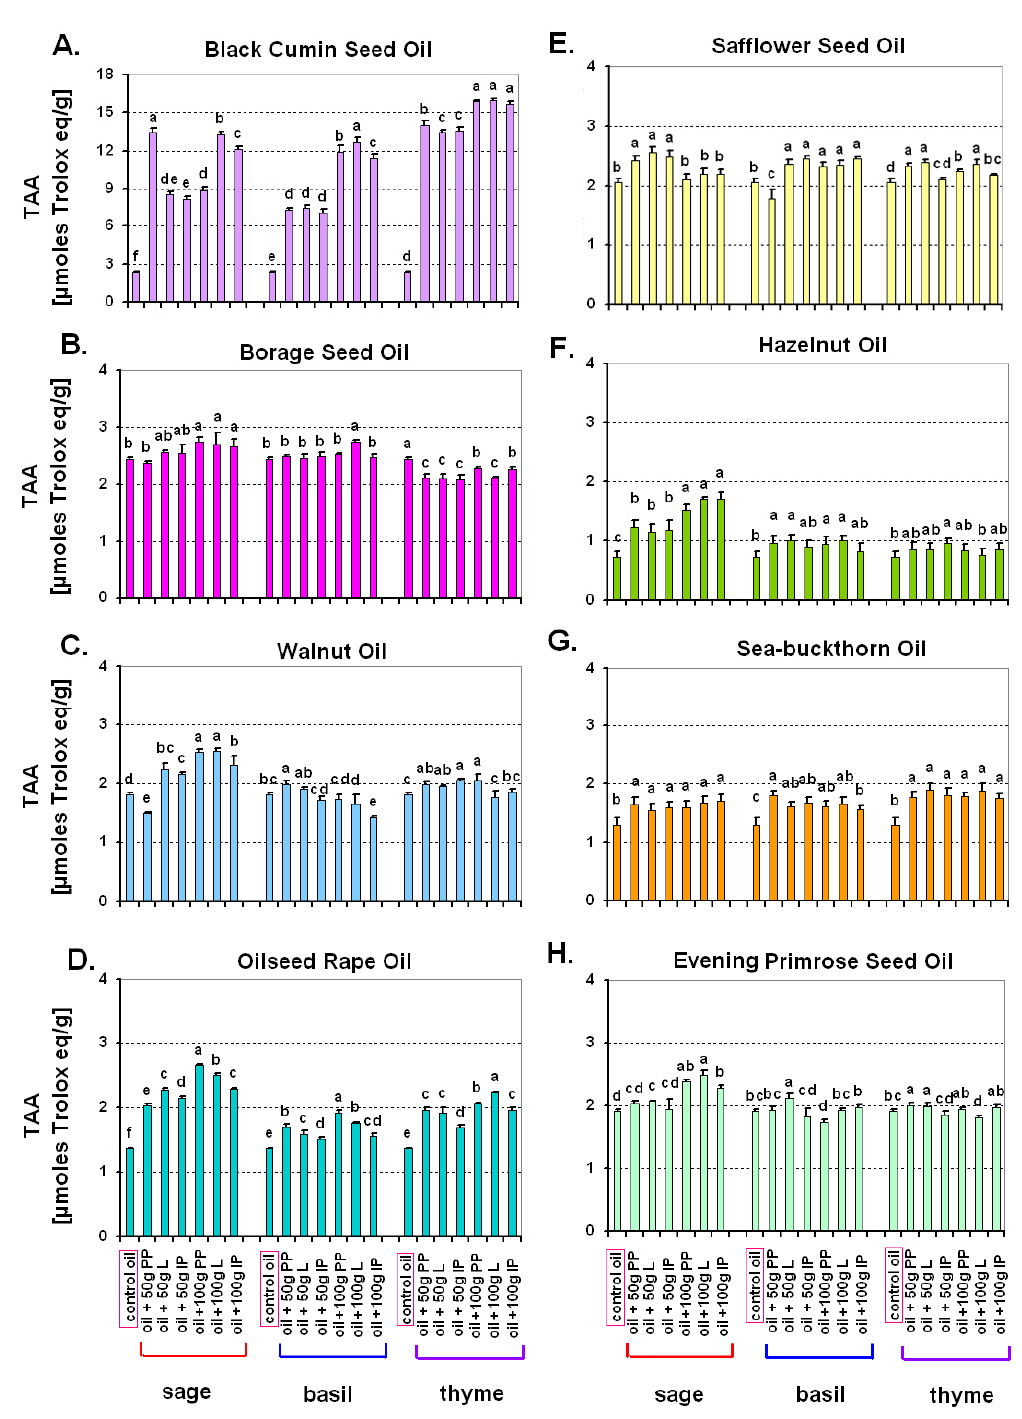
Figure 2. The impact of the addition of herbs (sage— Salvia officinalis L., basil— Ocimum basilicum L., thyme— Thymus vulgaris L.) on total low molecular weight antioxidant activity (TAA) of oils cold-pressed from the seeds of eight different species. ( A ) Black Cumin Seed Oil, ( B ) Borage Seed Oil, ( C ) Walnut Oil, ( D ) Oilseed Rape Oil, ( E ) Safflower Seed Oil, ( F ) Hazelnut Oil, ( G ) Sea-buckthorn Oil, ( H ) Evening Primrose Seed Oil. Control oil—cold-pressed oil without any additives. Values marked with the same letters are not significantly different according to a Duncan test ( p ≤ 0.05); statistical analyses made separately for individual herbs. PP—aerial plant part cut into pieces; L—leaves only; IP—intact aerial plant